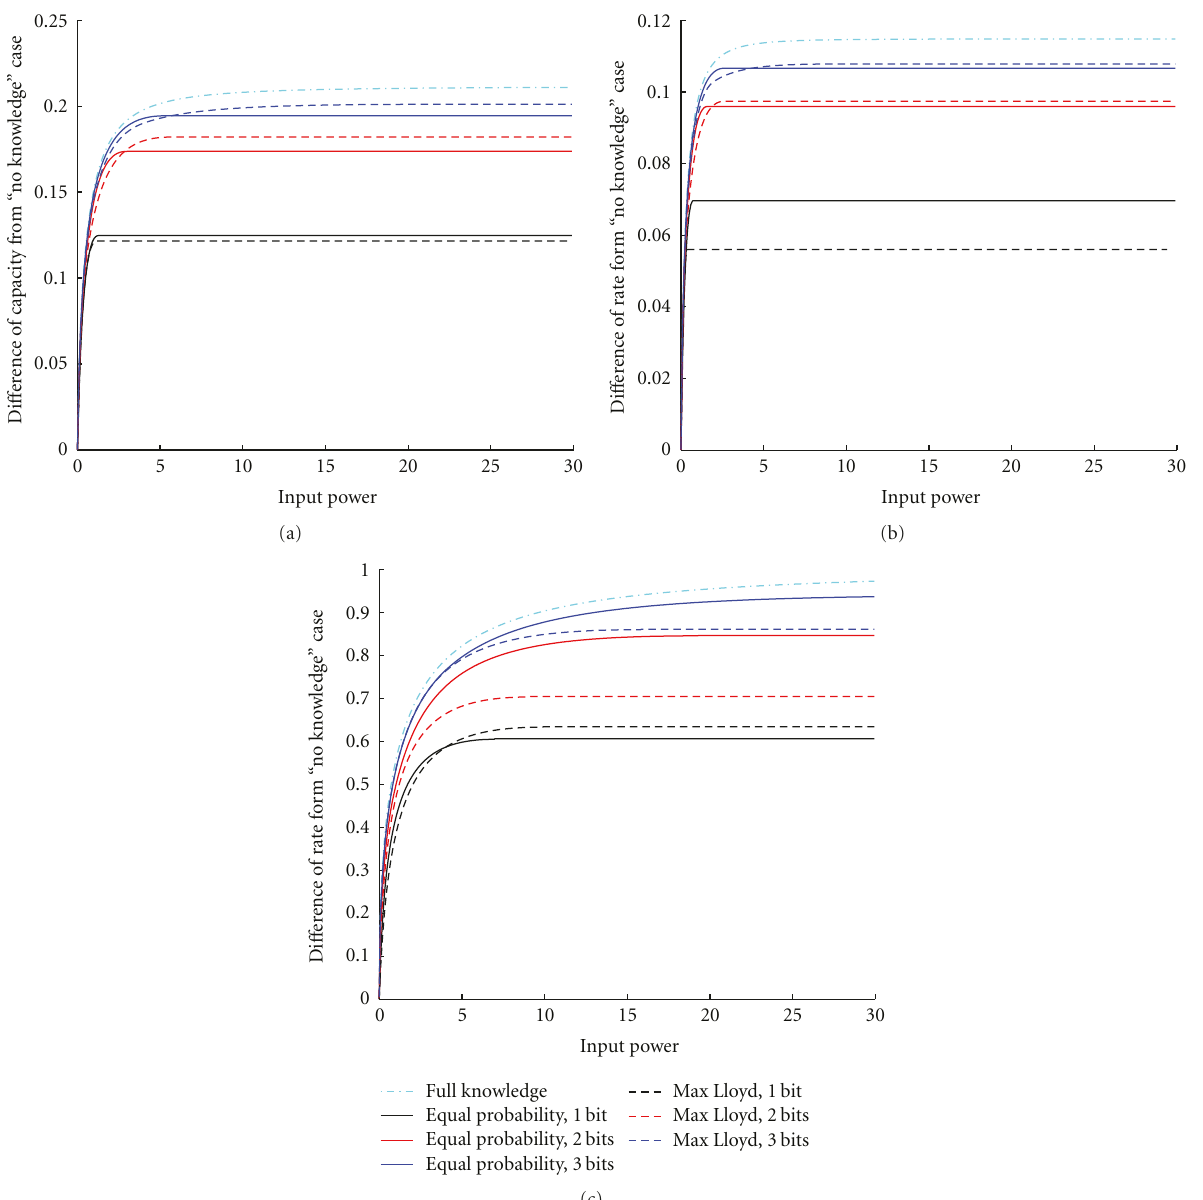
Figure 5: Increase in achievable rates relative the “no knowledge” lower bound using Max-Lloyd and equal probability quantizations. (a) Nakagami μ = 2, (b) Nakagami μ = 3, (c)